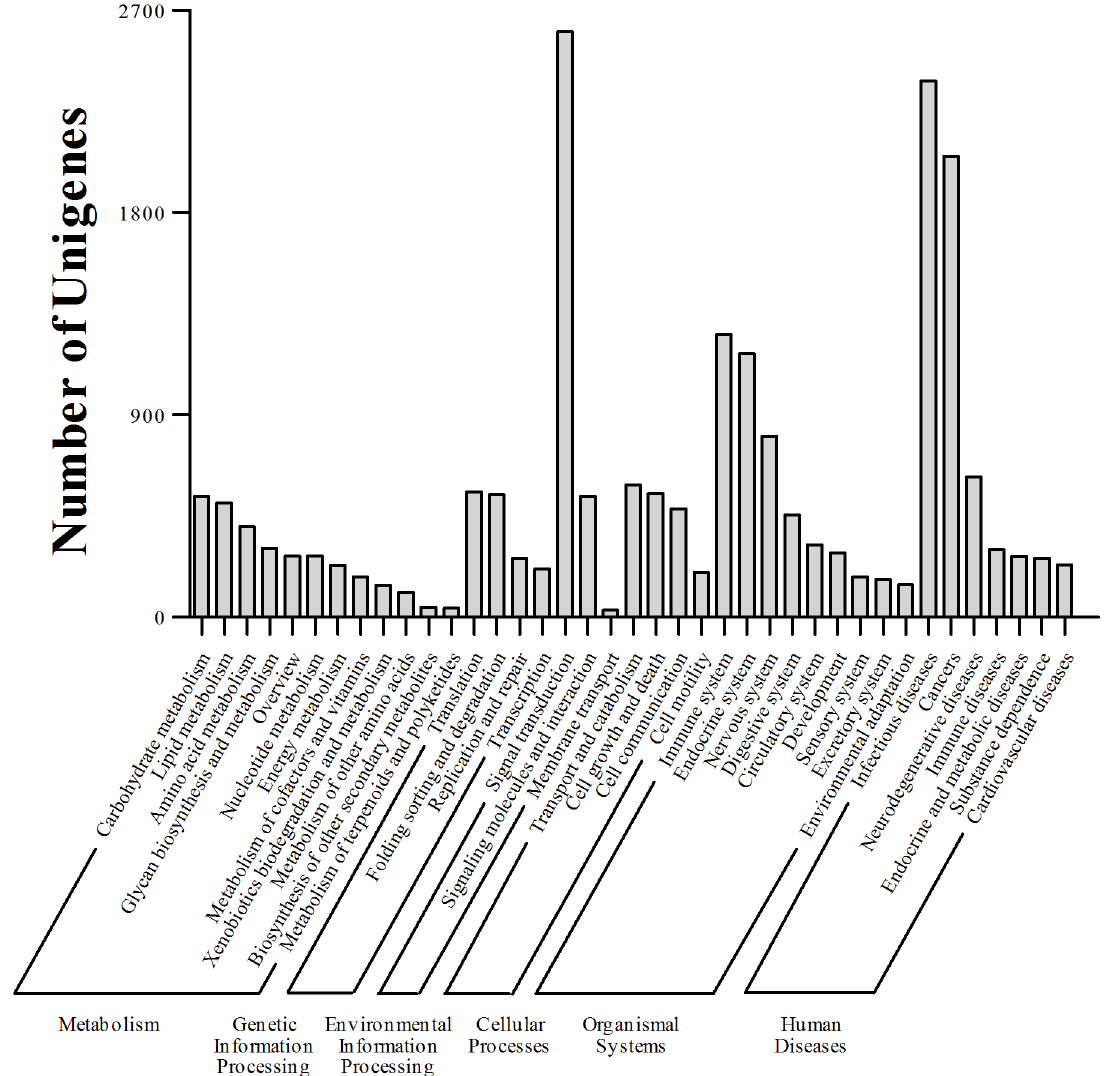
Fig 4. KEGG pathway in hierarchy 2. Unigenes were classified in metabolism, genetic information processing, environmental information processing, cellular processes, organismal systems and human diseases categories.